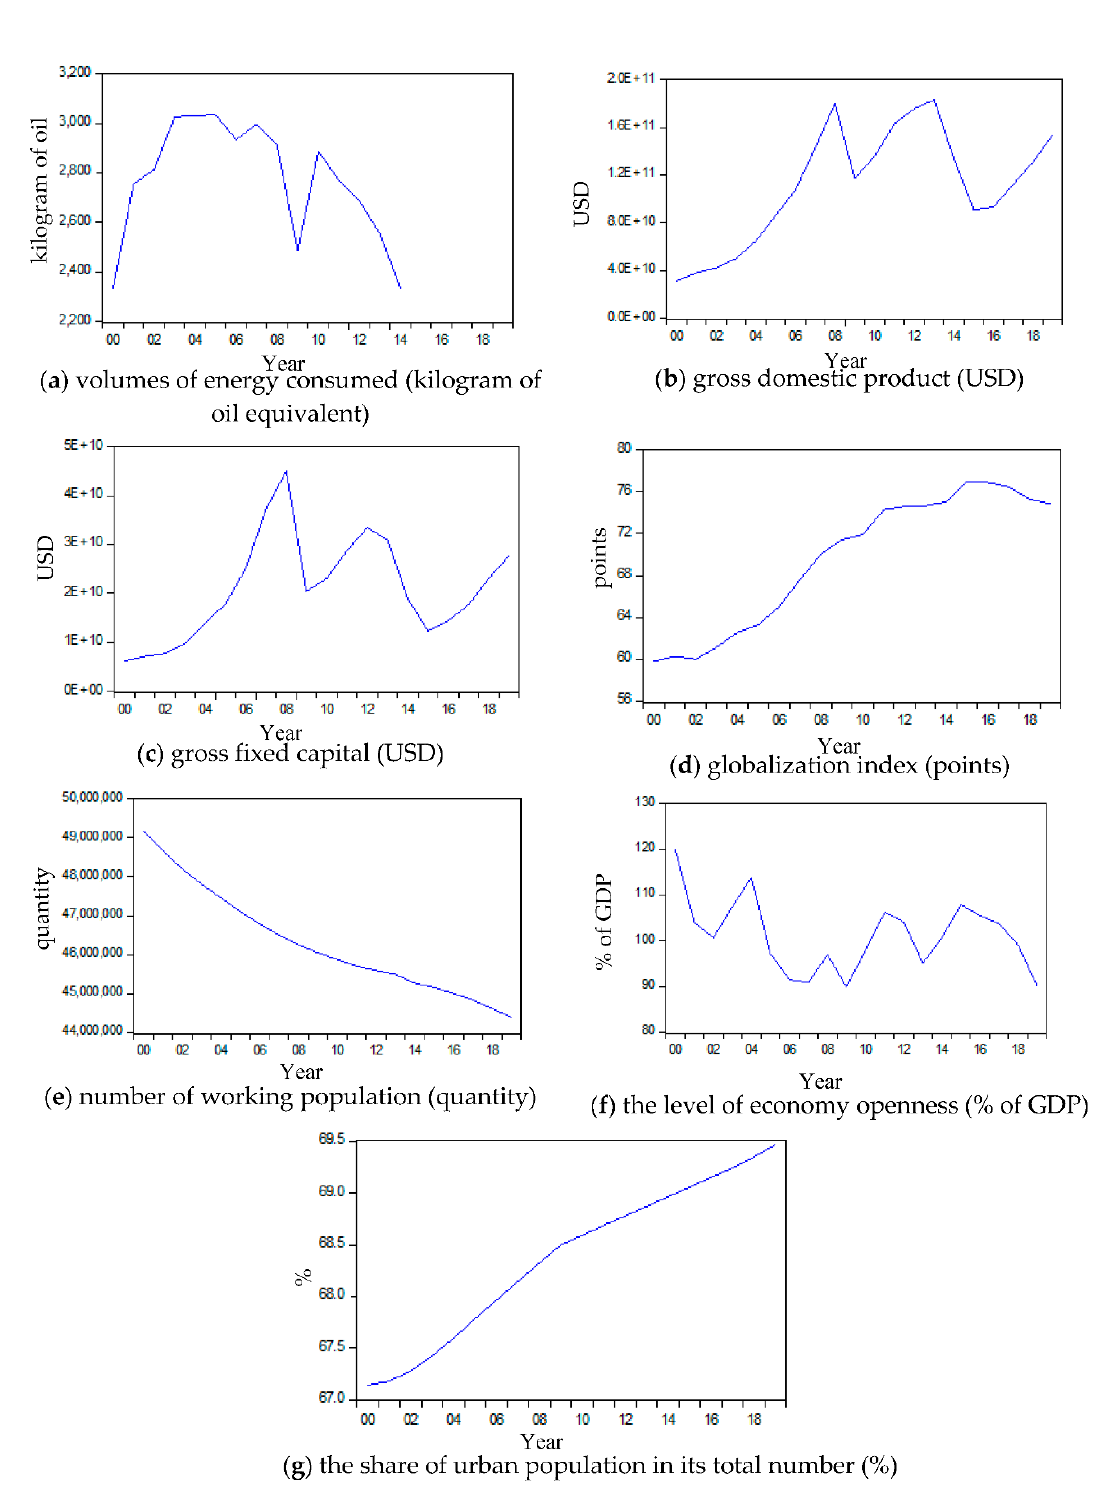
Figure 1. Graphical interpretation of initial data for estimating energy efficiency gaps in Ukraine,